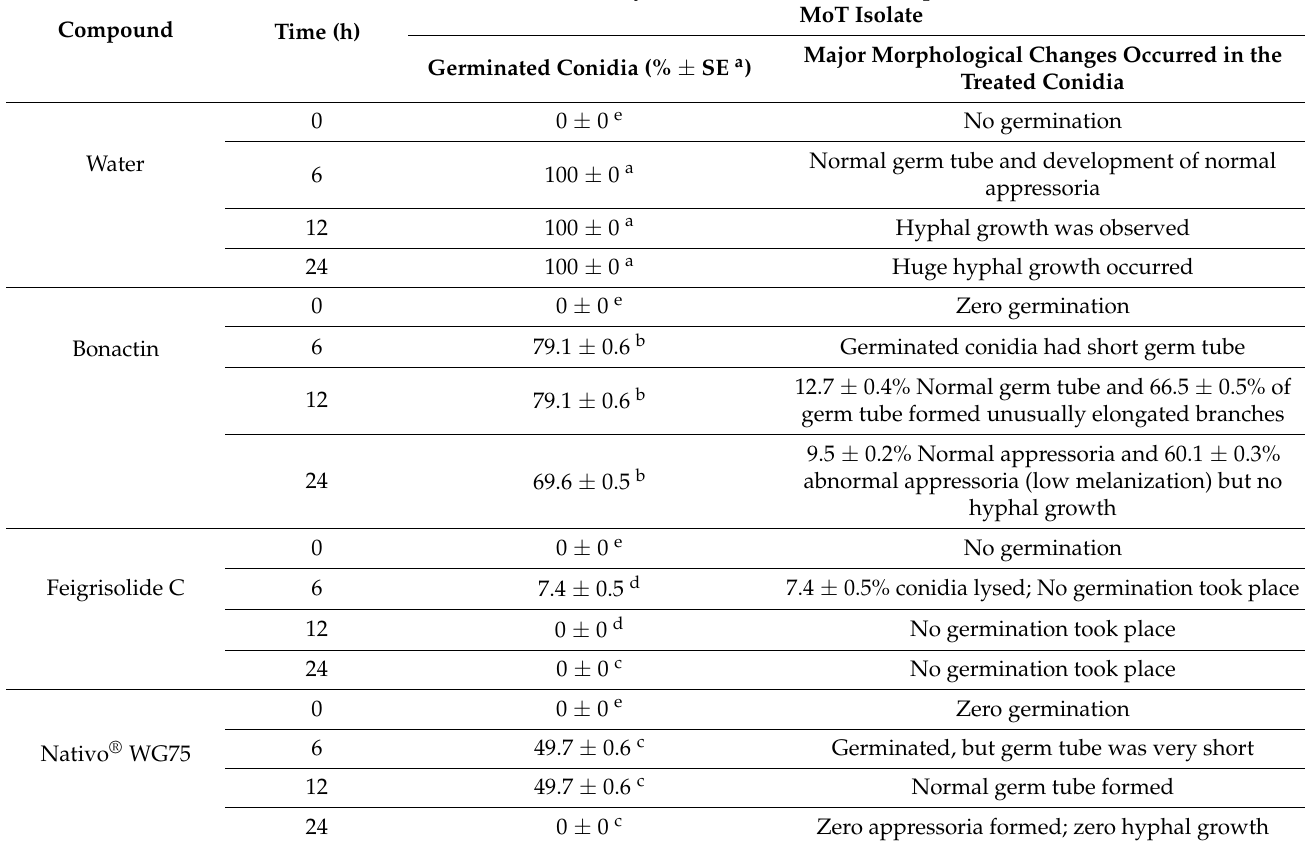
Table 1. In vitro effects of bonactin and feigrisolide C on conidia germination and the